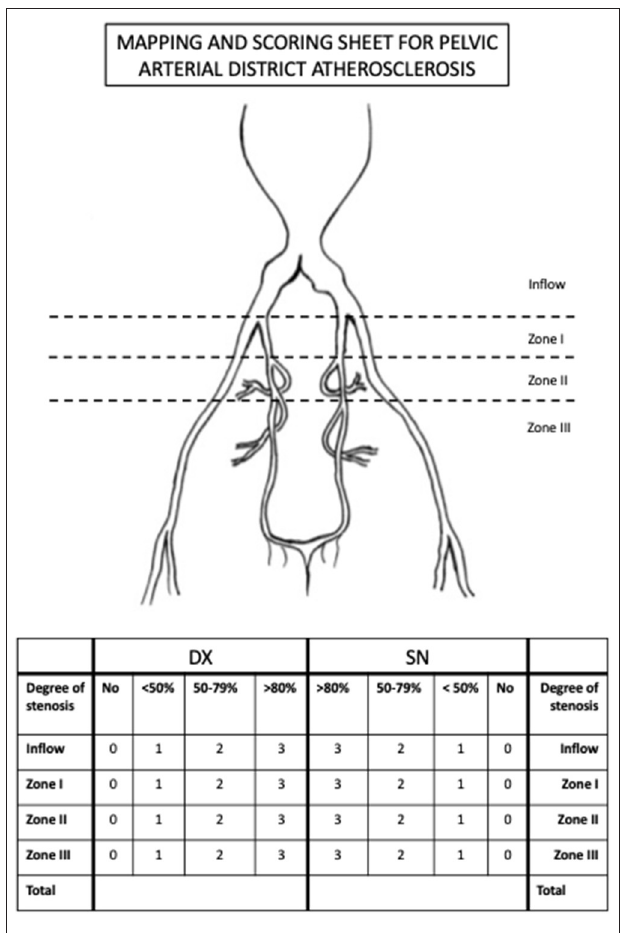
FIGURE 2 | The “MAPPING AND SCORING SHEET” tool used for the evaluation of the steno-occlusive disease of the pelvic arterial